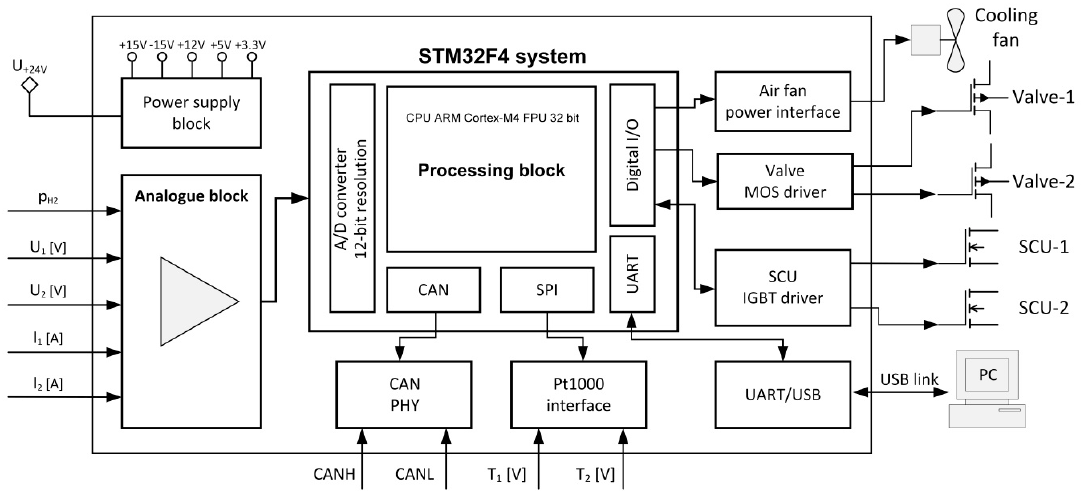
Figure 4. Diagram of the MCU-based controller of the fuel cell stack.